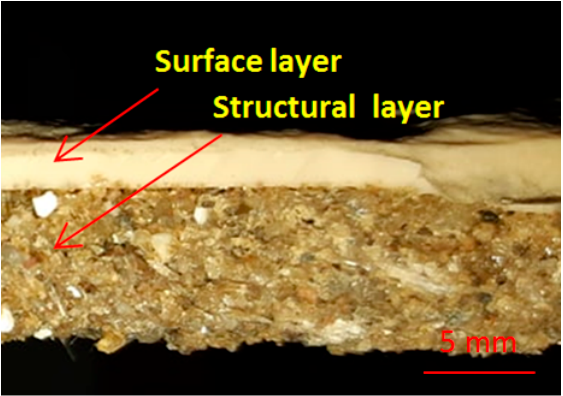
Figure 2. The ornamental synthetic stone plate: Interface between surface layer and structural composite material